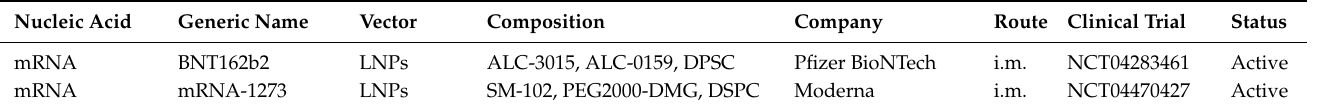
Table 2. Non-viral gene vectors for COVID-19